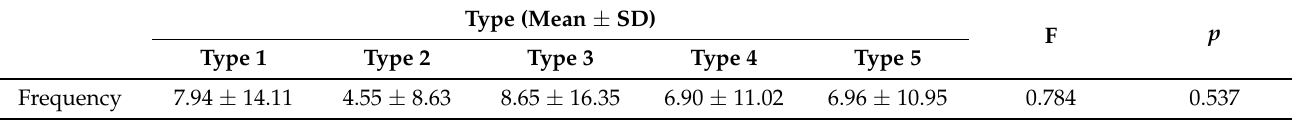
Table 24. Analysis of variance of eye movement times of different size keys.